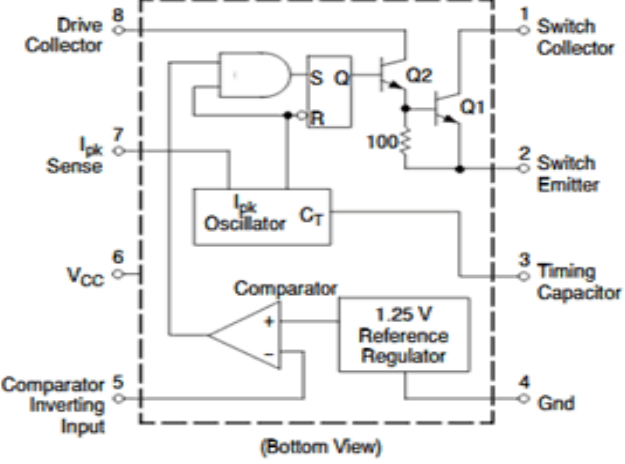
Figure 4. The microcircuit